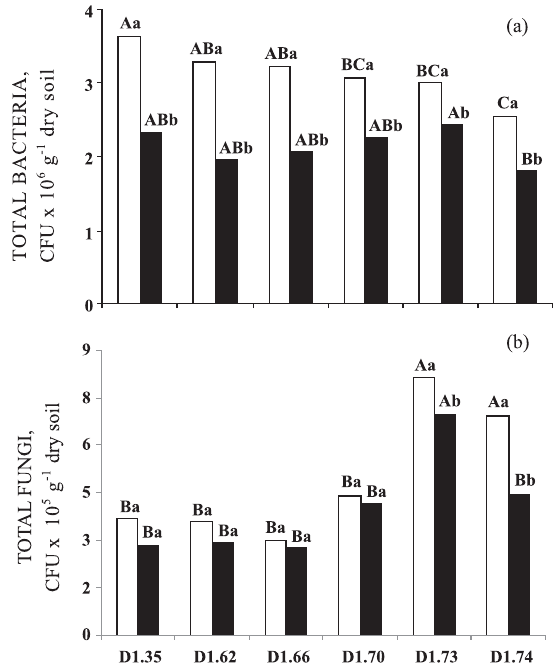
Figure 1. Bacteria (a) and fungi (b) populations observed in the layers 0–10 ( ) and 10–20 cm ( ) of the soil. Bars with the same letter